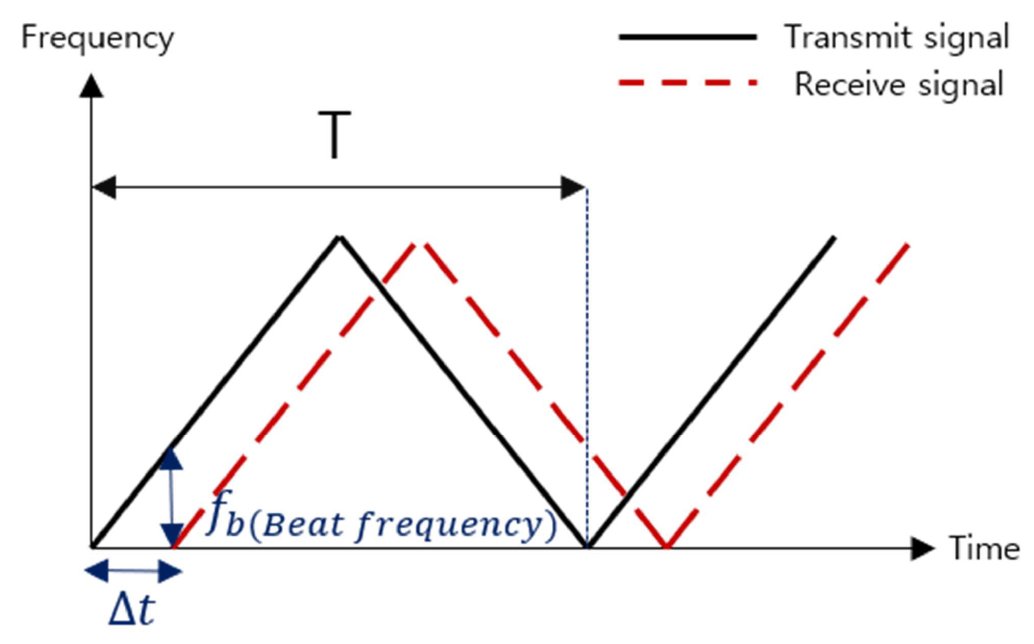
Figure 1. FMCW radar signal pattern.